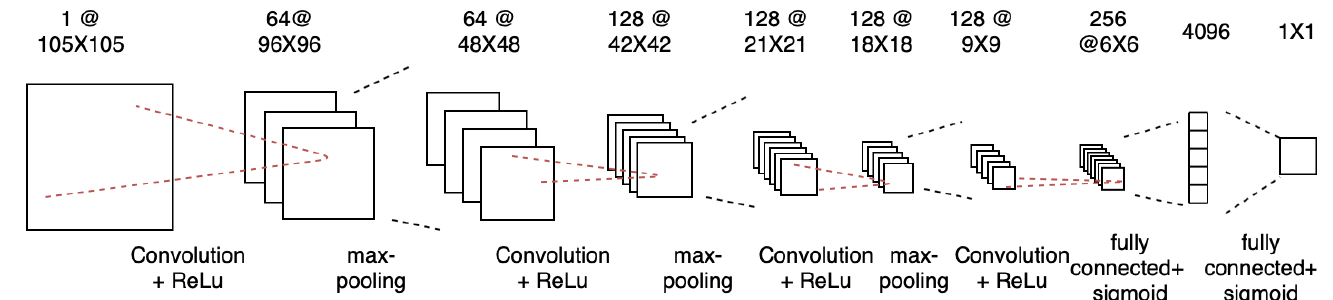
Figure 5. Architecture of a single convolutional neural network used in Siamese